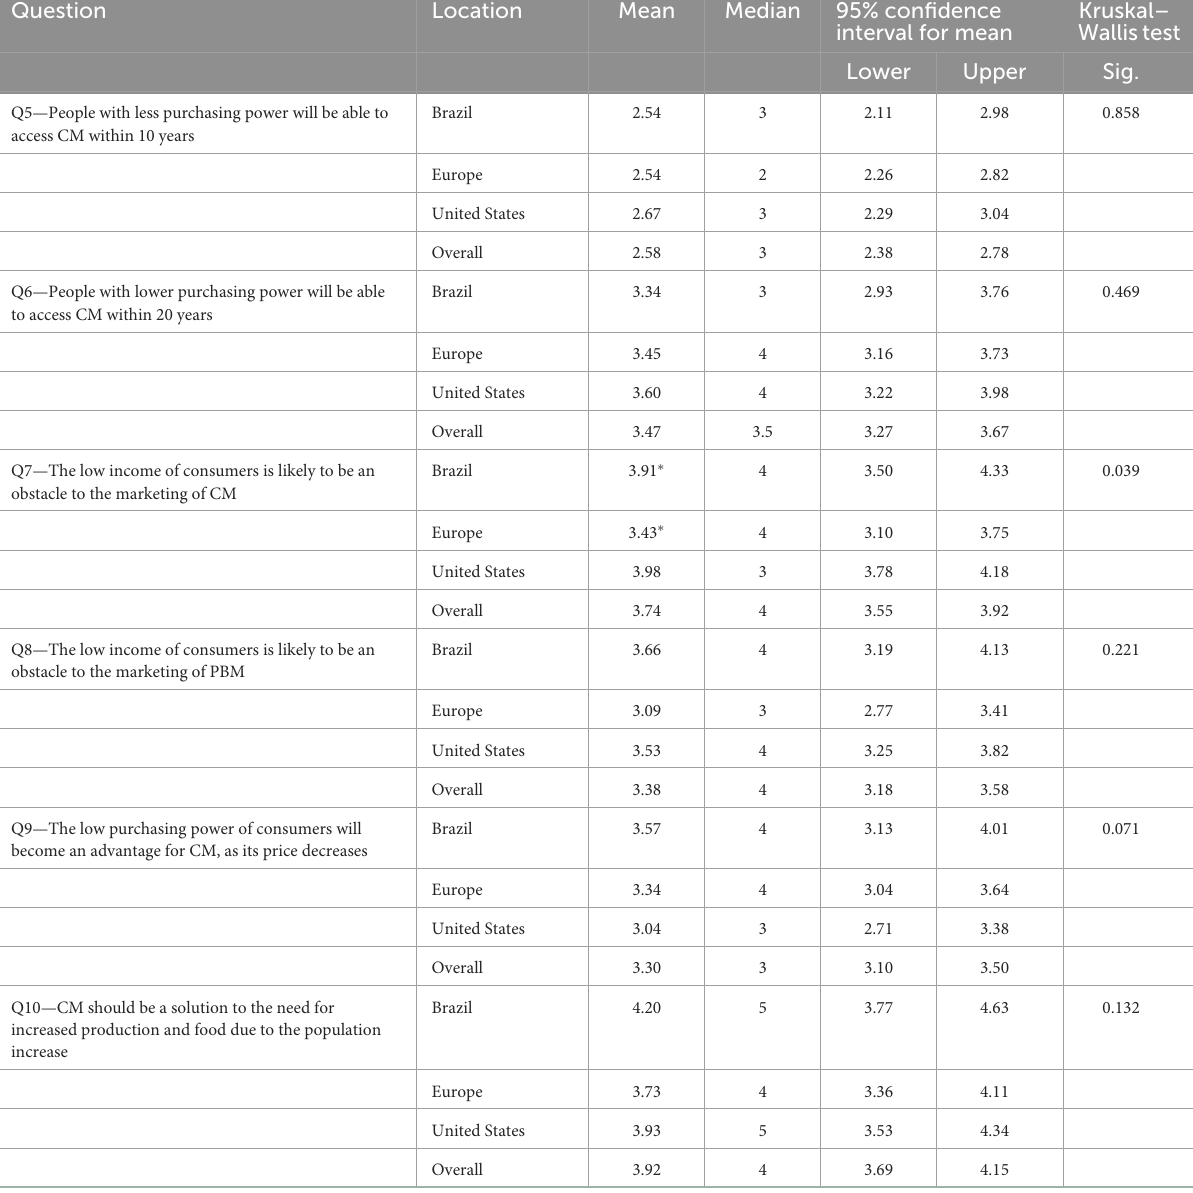
TABLE 3 Analysis for Q5–Q10 regarding consumer access in Brazil ( N = 35), Europe ( N = 56), and the United States ( N = 45) using Likert scale from 1 (strongly disagree) to 5 (strongly agree), as per interviews from August to October, 2021. Question Location Mean Median 95% confidence